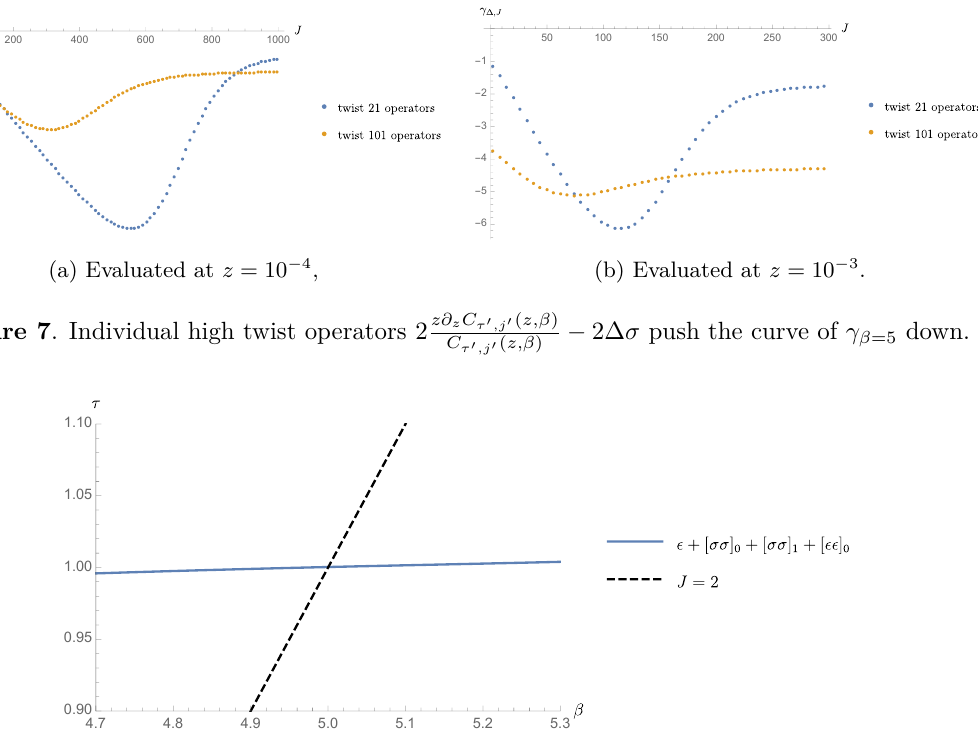
Figure 8 . τ ( β ) in the vicinity of β = 5 . The intersection between τ ( β ) and the line J = 2 gives the location of the stress-tensor.